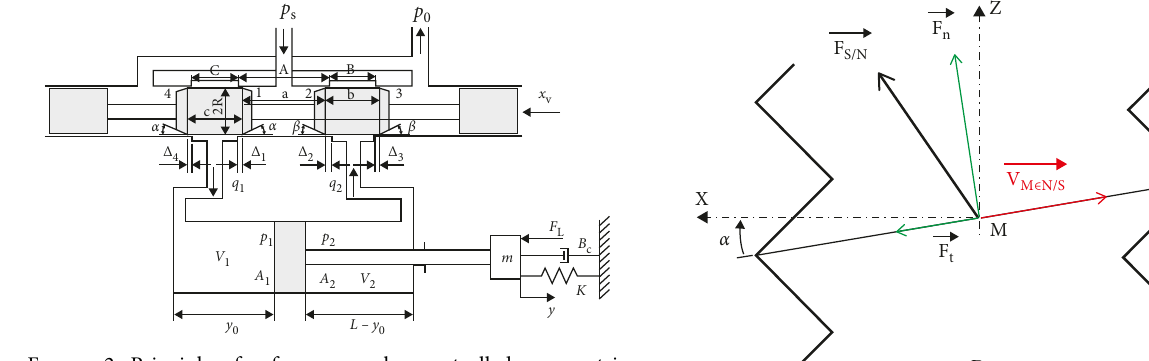
Figure 2: Principle of a four-way valve controlled asymmetric hydraulic cylinder [11].